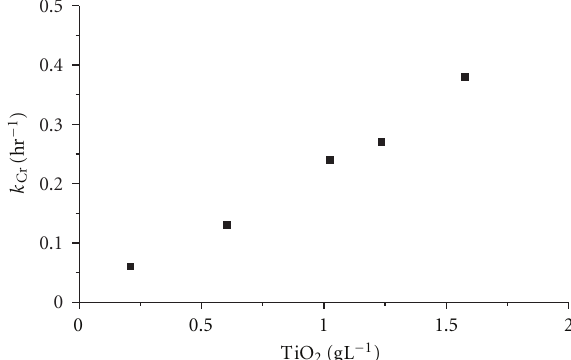
Figure 2: Relationship of the rate constant on the photocatalytic